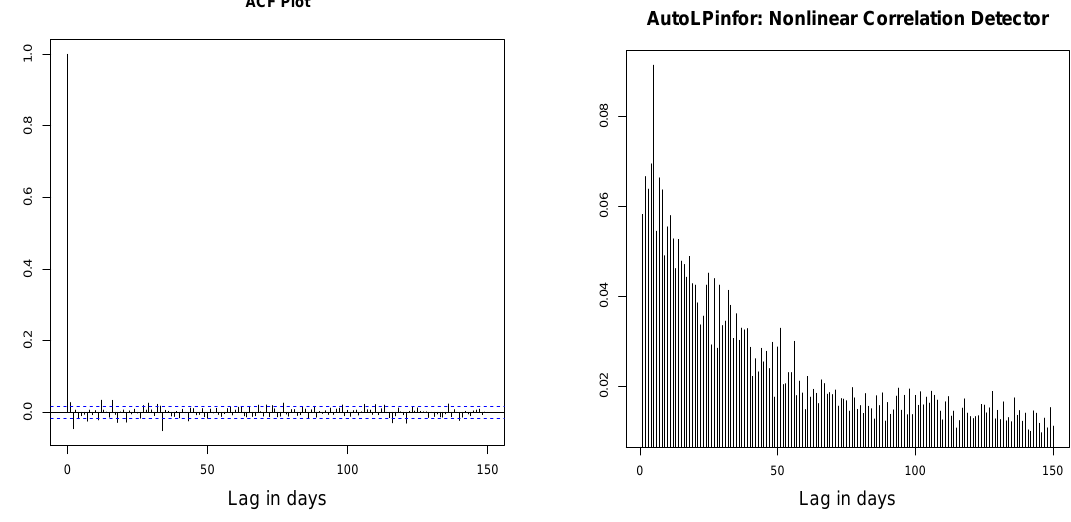
Figure 5. Left : ACF plot of S&P 500 data. Right : AutoLPinforPlot up to lag 150.